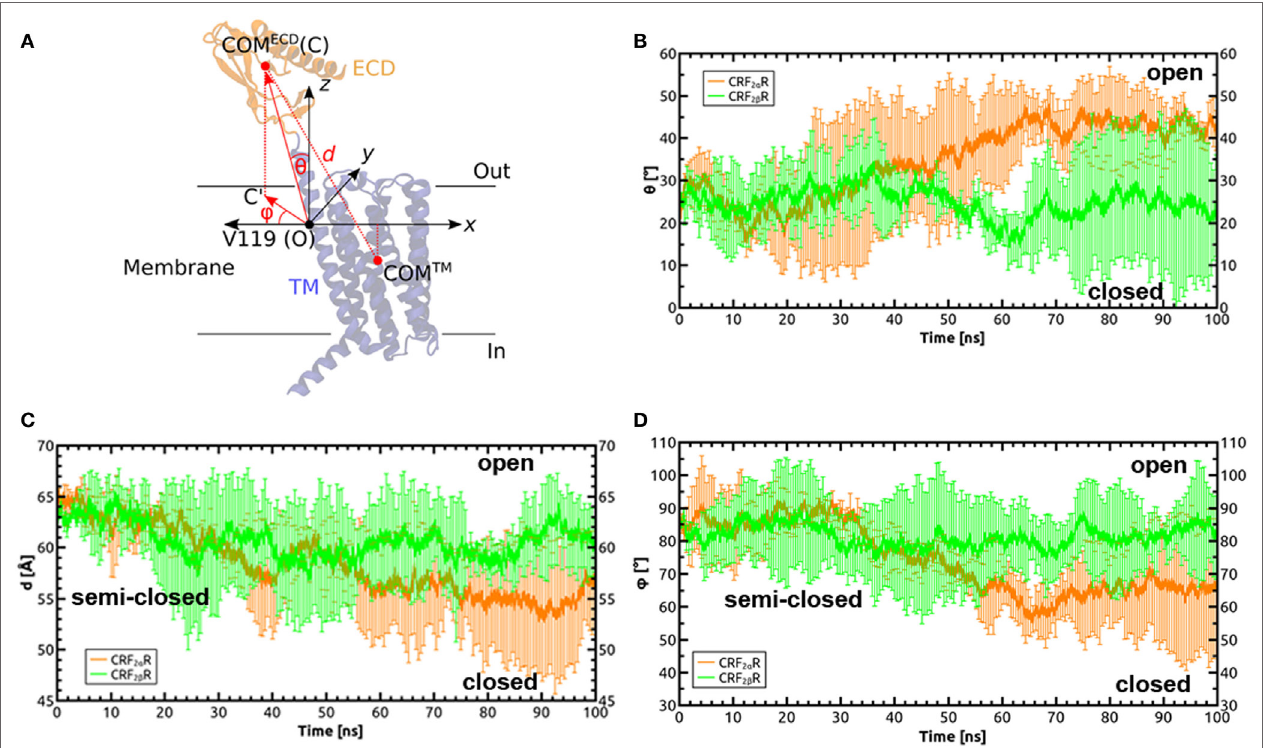
FigUre 6 | Defining orientation angles in the CRF 2 α / β R system. (a) Cartesian coordinate system defined to calculate the polar ( θ ) and Azimuthal ( φ ) angles, in order to define the relative orientations of the extracellular domain (ECD) with respect to the TM domain and the membrane plane during the molecular dynamics simulation of the receptors. The theta angle is defined as the angle between the vector formed by the origin (O) and the center of mass (COM) of the ECD (c) : OC with the z axis (perpendicular to the membrane plane). The phi angle is defined as the angle between the vector formed by the projection of the OC vector on the (cid:31) (cid:30)(cid:31)(cid:31)(cid:31) membrane plane (OC ’ ) and the x axis. Valine 119 in TM1 of the TM domain of CRF 2 α R was identified as the residue around which the helix bends to facilitate motions of the ECD. (B–D) Time dependences of θ , d , and ϕ in the MD simulations on CRF 2 α R (orange lines) and CRF 2 β R (green